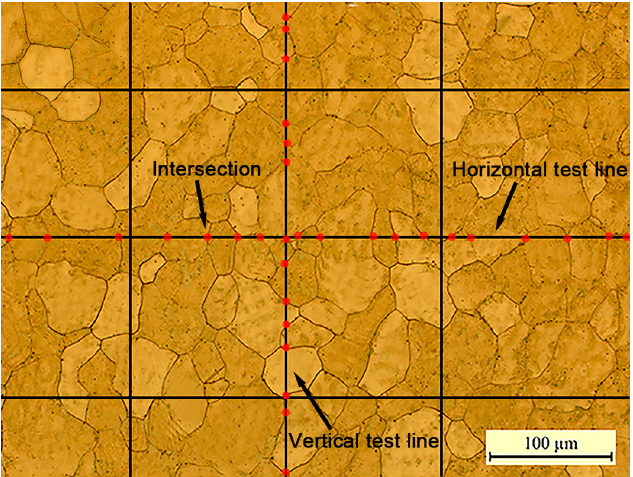
Figure 4. Sketch of the line intercept method.